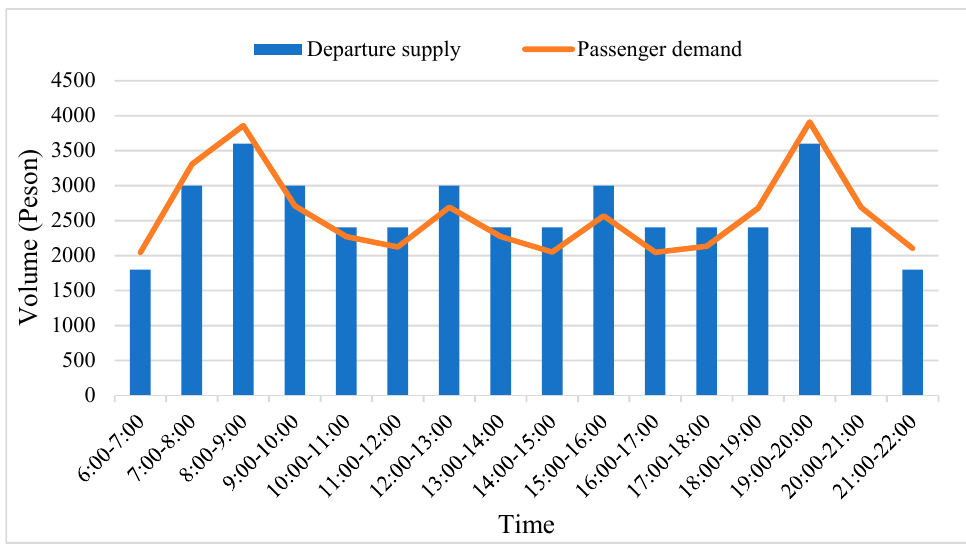
Figure 11. Supply and demand matching diagram of intercity railway. Table 17. Details of supply and demand matching degree of multi-cycle timetable of intercity railway